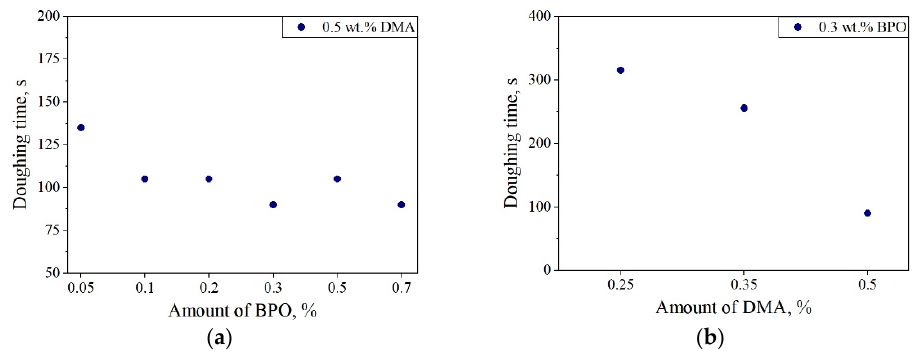
Figure 4. Doughing time of bone cement containing ( a ) 0.5 wt.% of DMA and different amounts of BPO initiators, and ( b ) 0.3 wt.% of BPO and various concentration of DMA co-initiator.